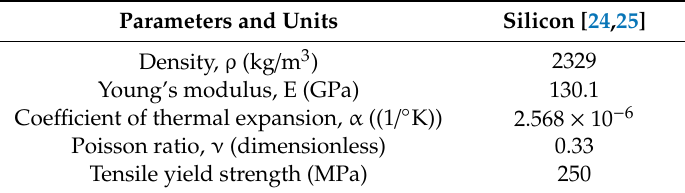
Figure 3. Frontal view of accelerometer: ( a ) uniform beam and ( b ) symmetrical beam. Table 3. Mechanical properties of